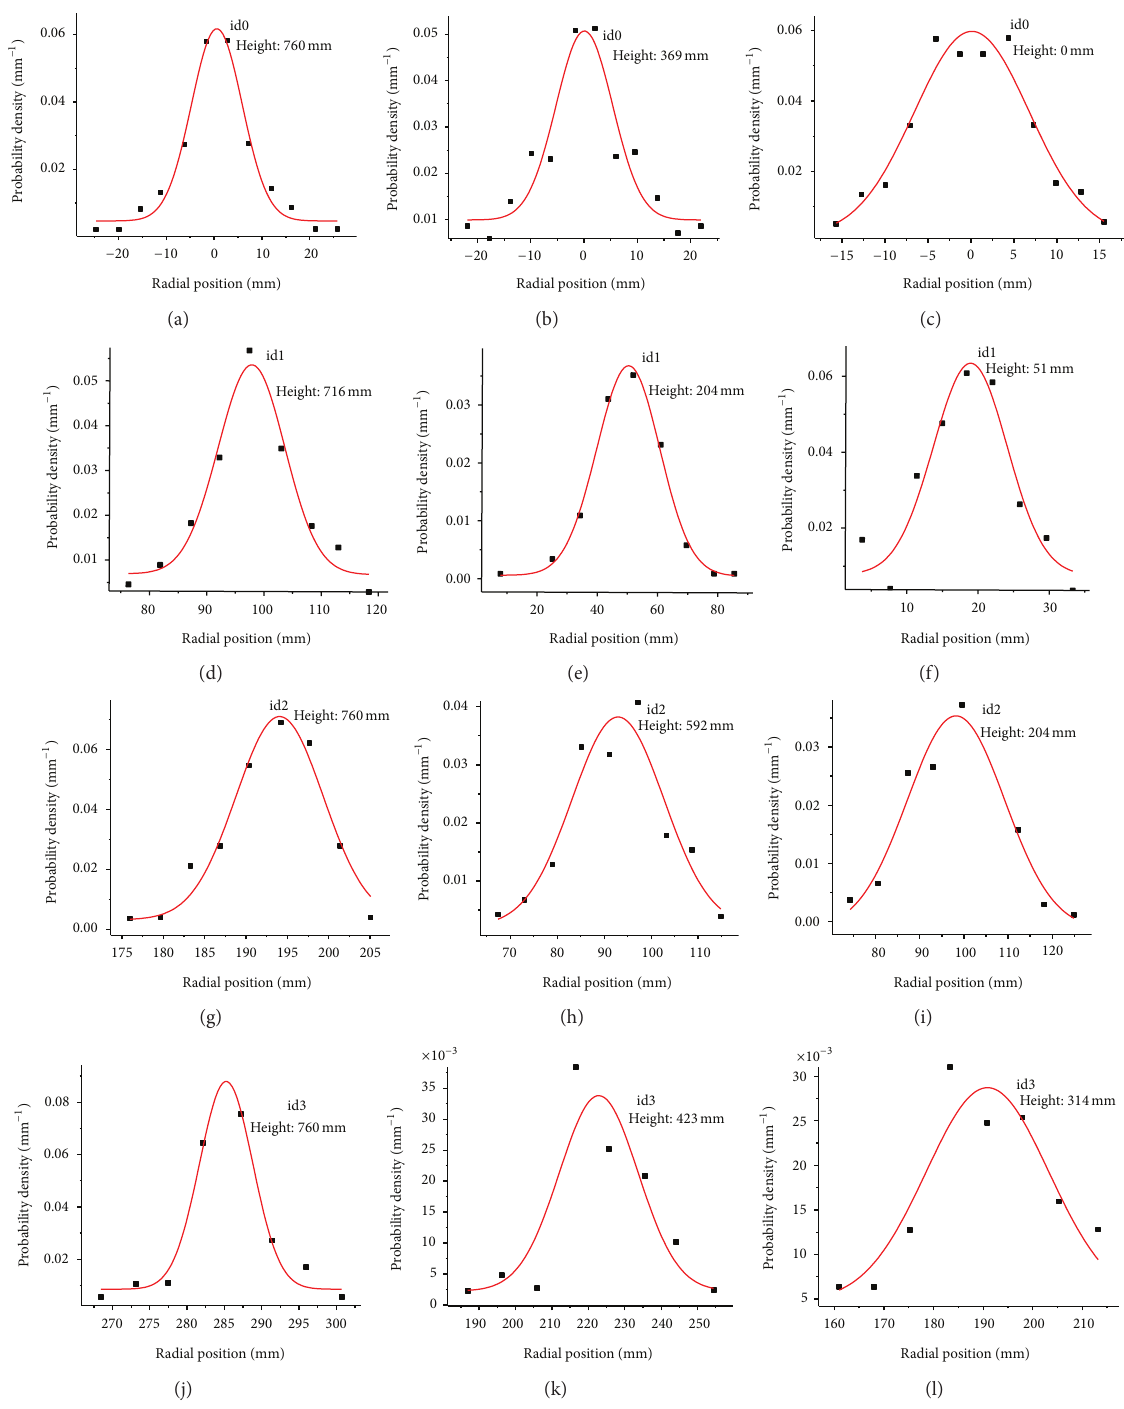
Figure 6: Coincidences between probability density points and fitting curve at different heights and radial positions.